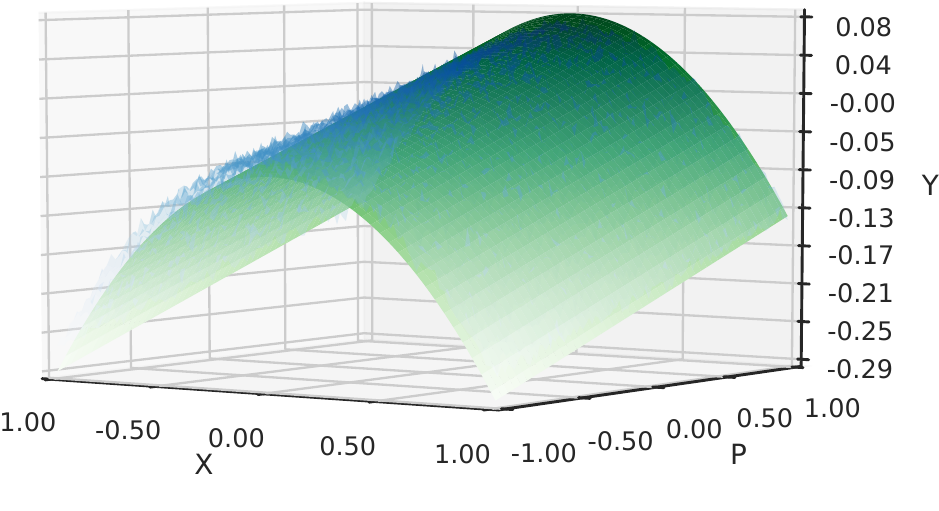
Figure 3. One-step prediction comparison of the test system (blue) and fitted model